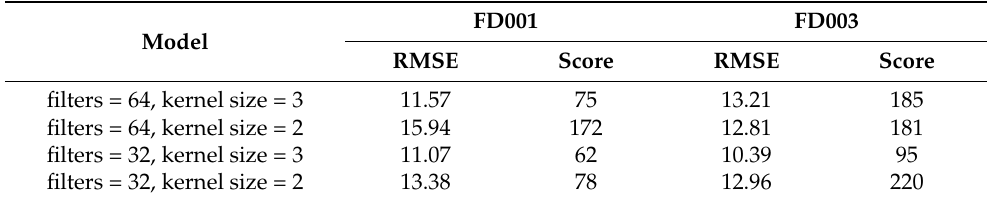
Table 5. Effect of different model parameters.